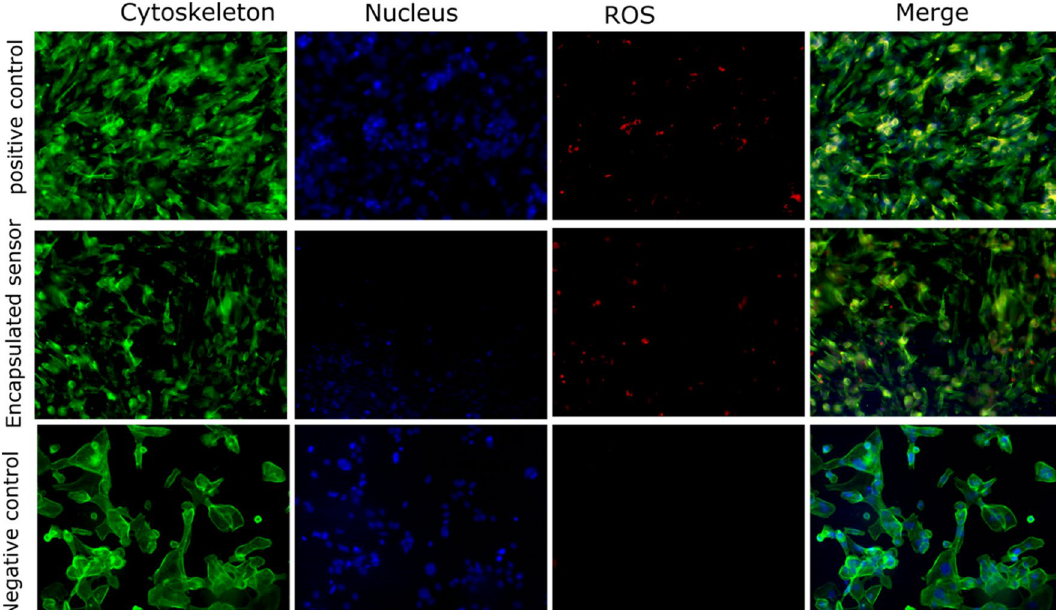
Figure 4. ROS generation assessment after a 24 h exposure to the different treatment groups on the epidermal cell line, HaCaT. Representative fluorescent images (magnification: 20x) captured after treatment with positive control (cells treated with 250 µM of hydrogen peroxide served as the positive control), an encapsulated sensor (encapsulated sensors fabricated using IC70 concentration of silver ink), and negative control (cells exposed to no treatment).